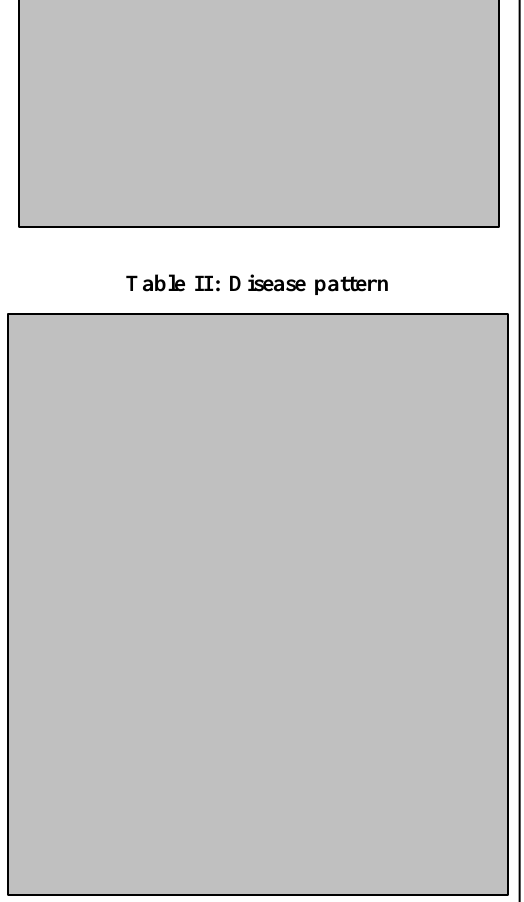
Table I : Age and sex distribution